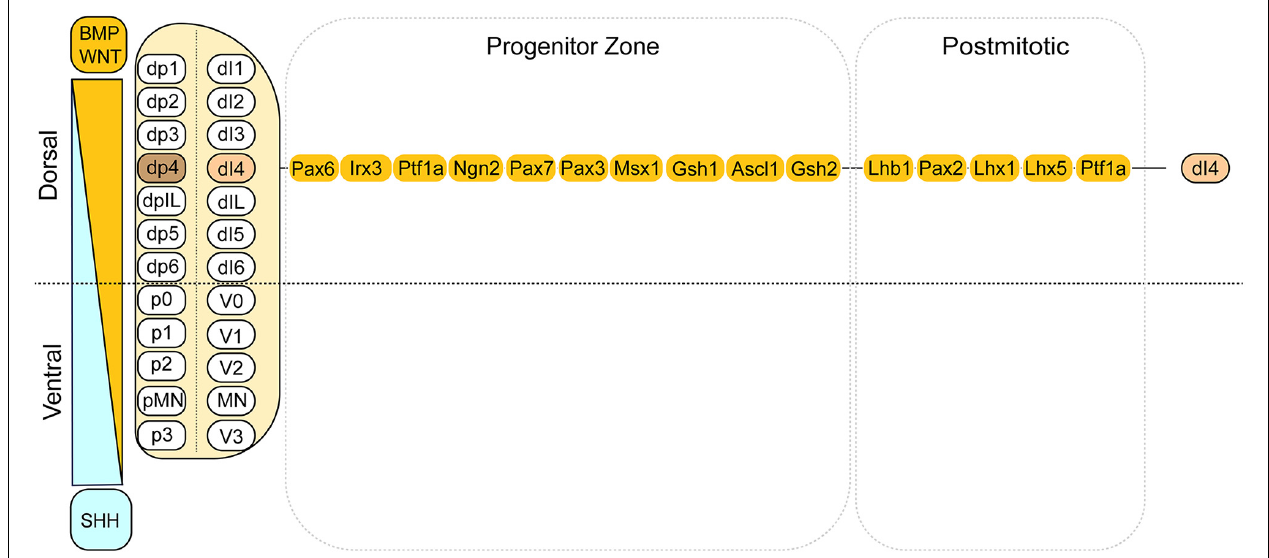
FIGURE 1 | Summary of the dorsal domains and the transcription factors associated with the dI4 INs. This cartoon illustrates the dorsal domains and the corresponding cell types derived. On the left side, it depicts the dorsally derived BMP and WNT gradient. On the right side, the transcription factors are listed for dI4 progenitors and post-mitotic neurons, respectively. Adapted from Alaynick et al. (2011) and Lu et al.